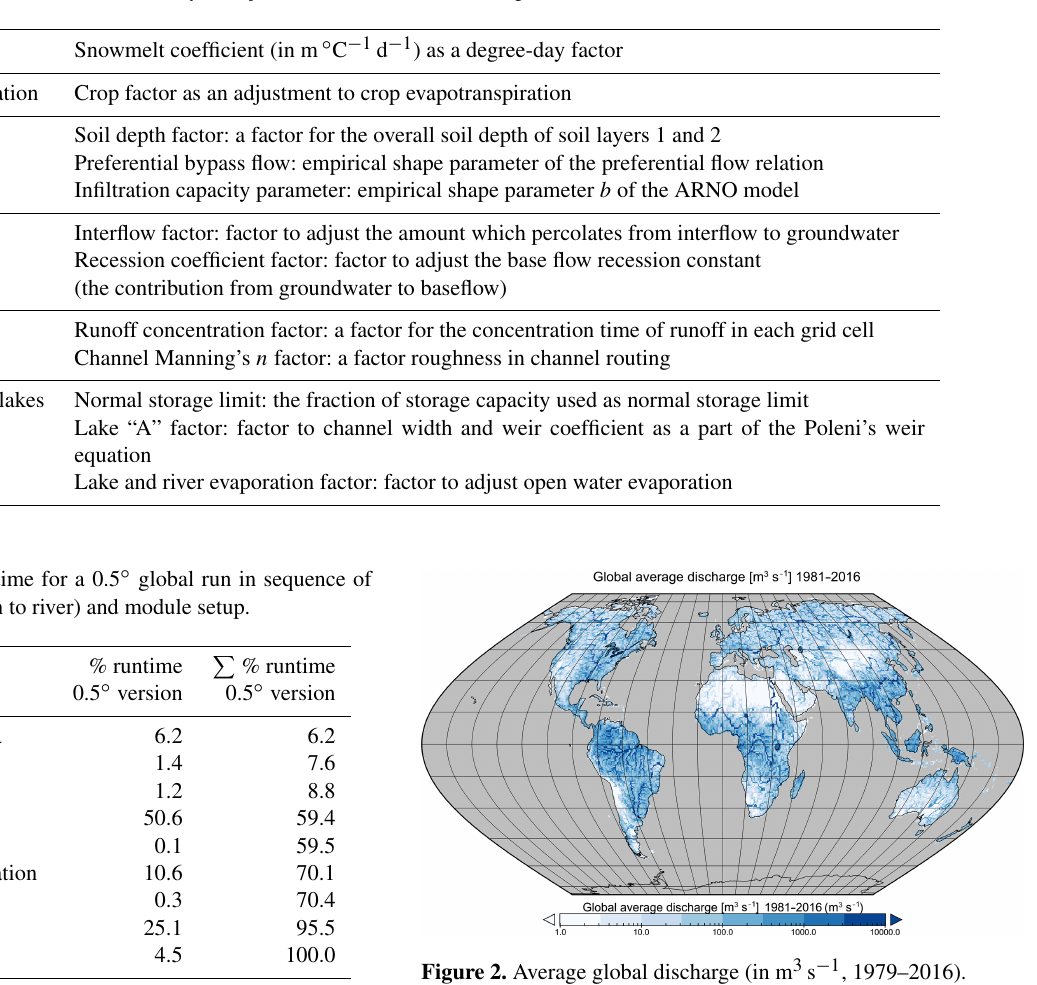
Table 2. Calibration parameters (with flexibility to adjust the number and different parameters).